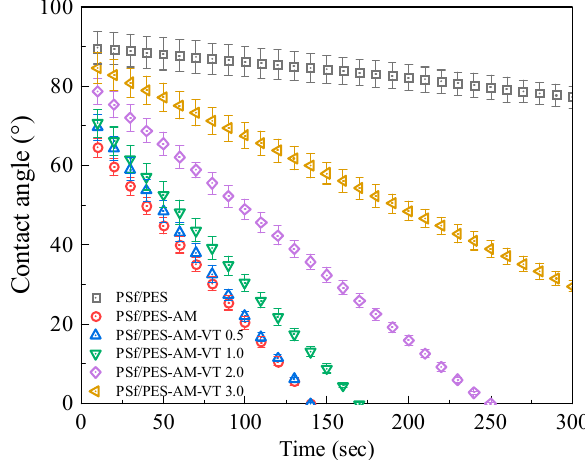
Figure 7. Time-dependent water contact angles of various membranes.